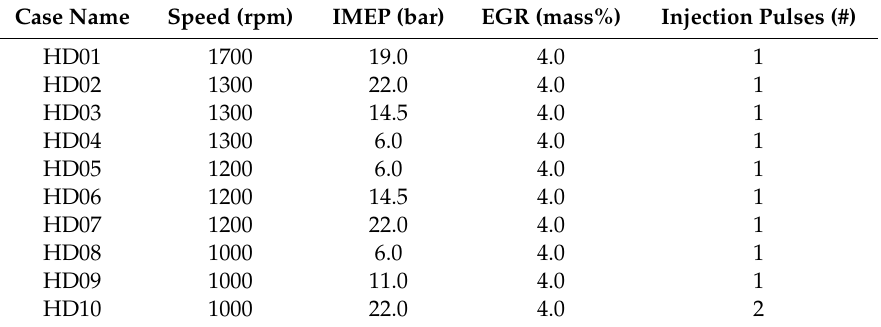
Table 2. Heavy-duty engine operating conditions.